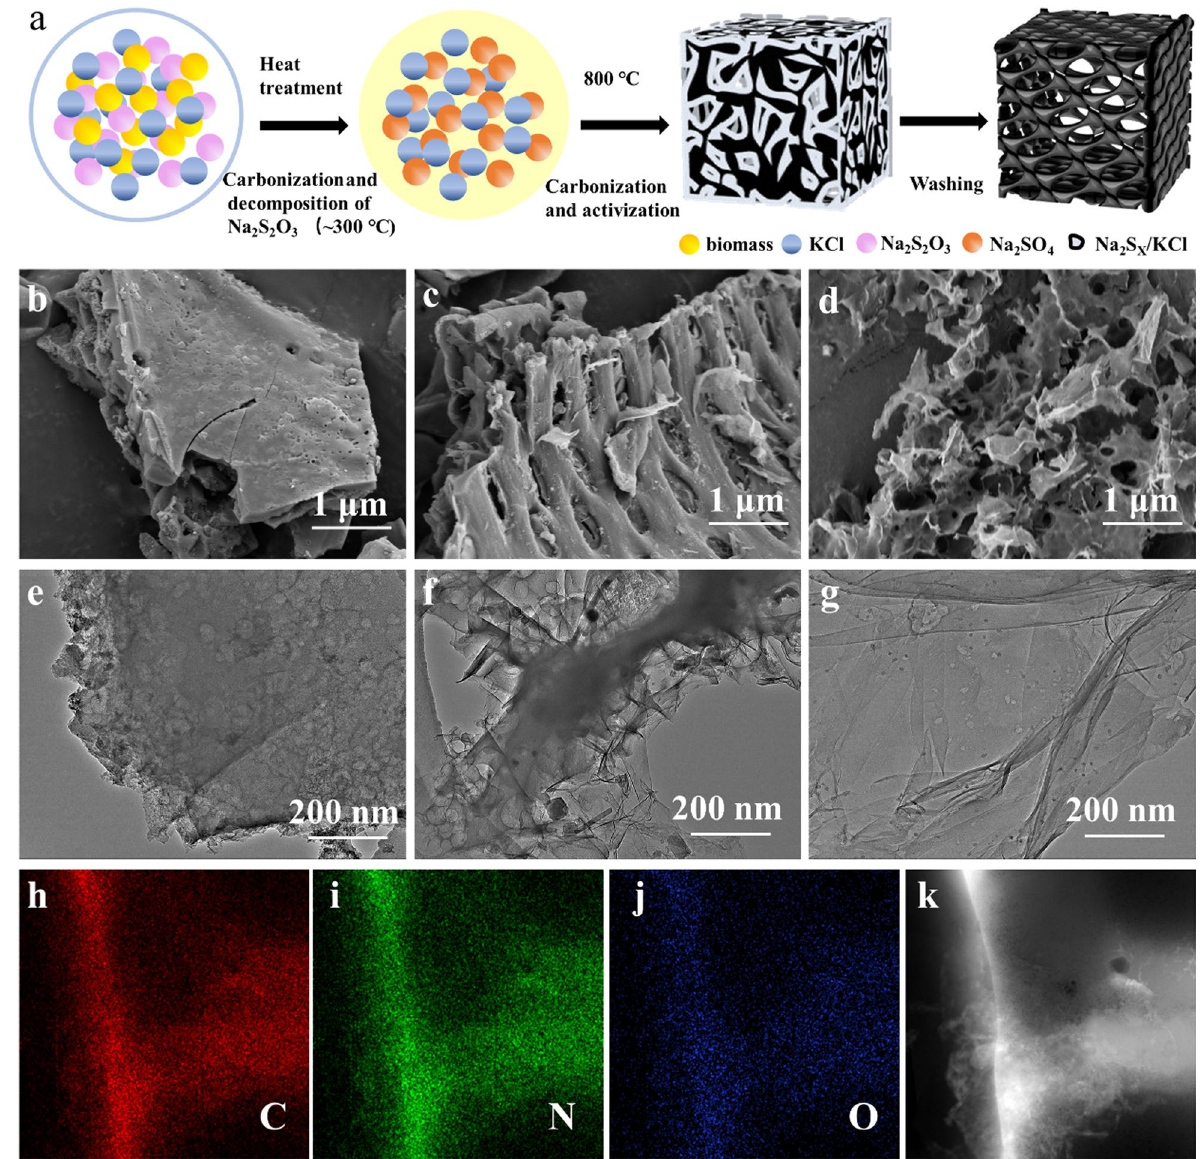
Fig. 1 Schematic illustrations of the synthesis procedure of the SK-C ( a ). SEM images of S-C ( b ), K-C ( c ) and SK-C ( d ). TEM images of S-C ( e ), K-C ( f ) and SK-C ( g ). High angle annular dark field scanning TEM image of ( k ) SK-C with energy-dispersive X-ray spectroscopy (EDS) elemental mapping of C ( h ), N ( i ) and O ( j